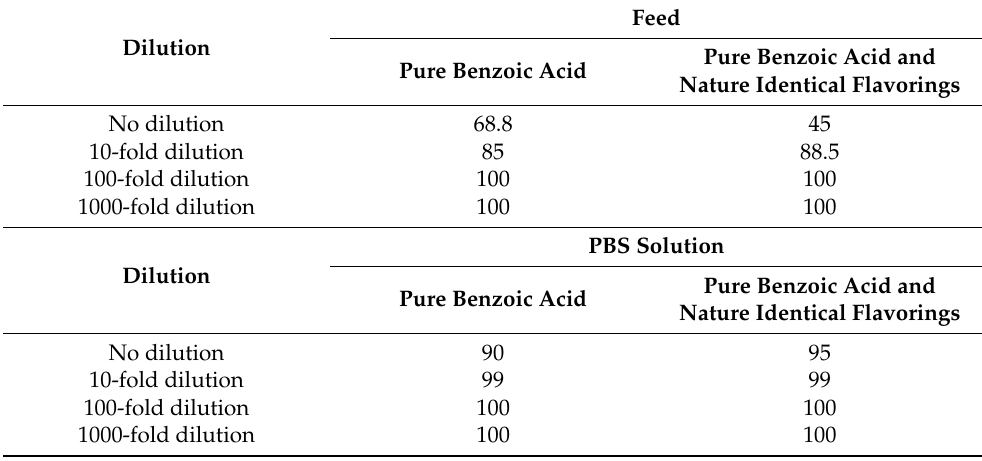
Table 2. Survival rate of cells in the presence of different dilutions of either the supernatant of feed or the phosphate-buffered saline (PBS) solution treated with pure benzoic acid or its combination with nature identical flavorings